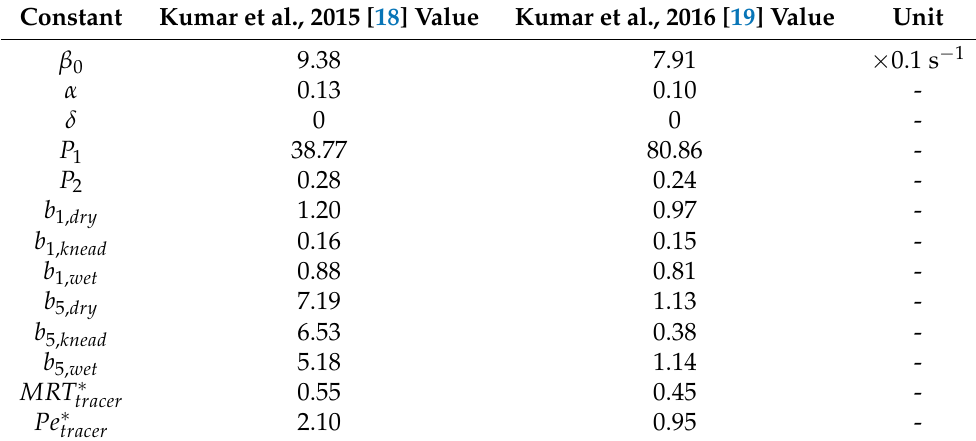
Table 2. The values of various model parameters estimated.